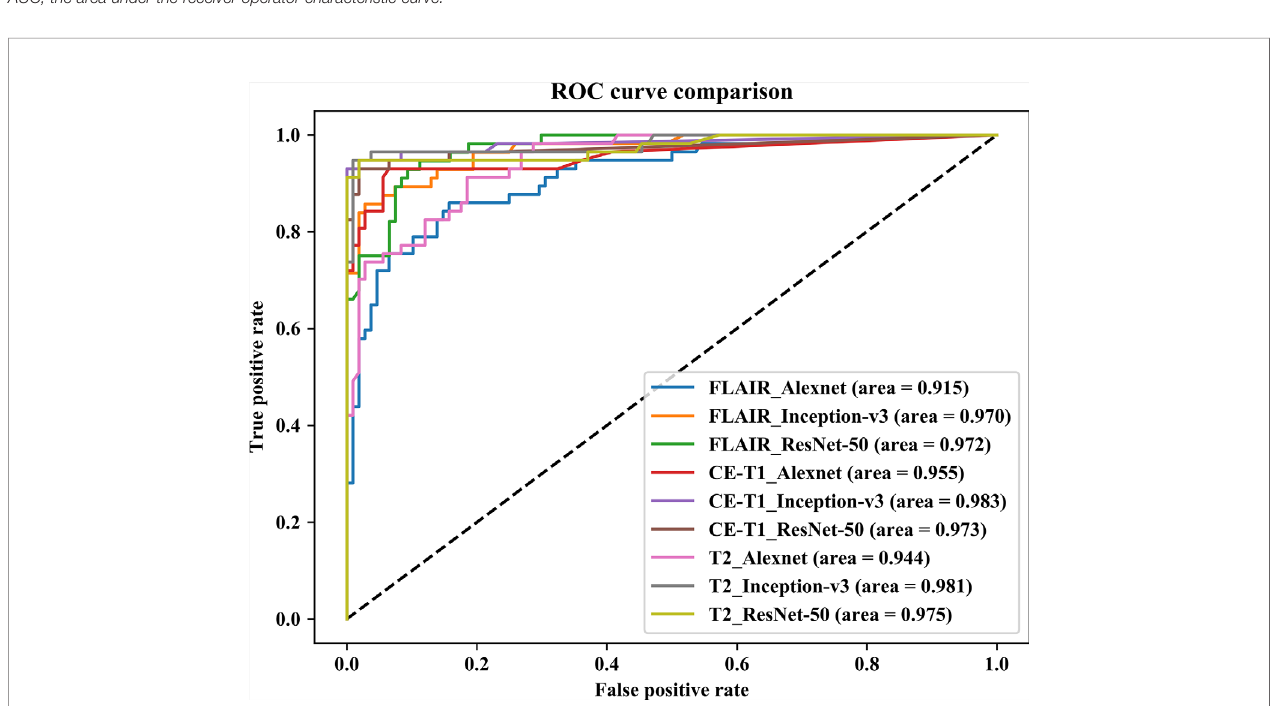
FIGURE 2 | Comparison of receiver operating characteristic curves of three pretrained CNN models based on three single MRI